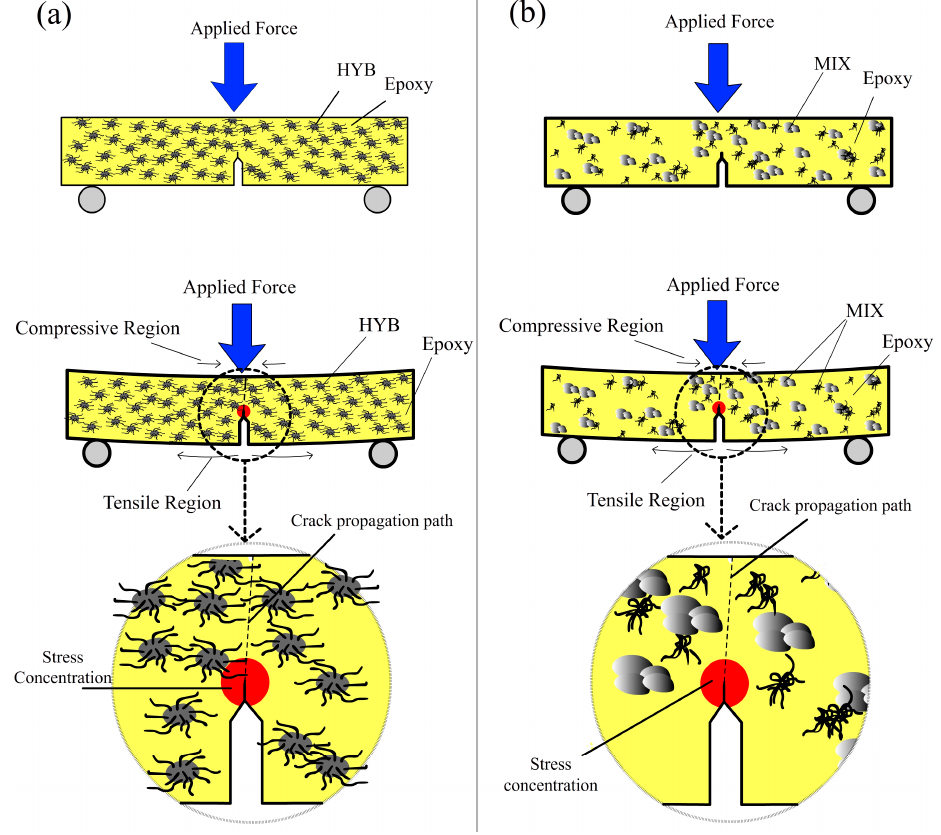
Figure 7. Schematic representation of the crack propagation in the ( a ) Epoxy/HYB and ( b ) Epoxy/MIX.